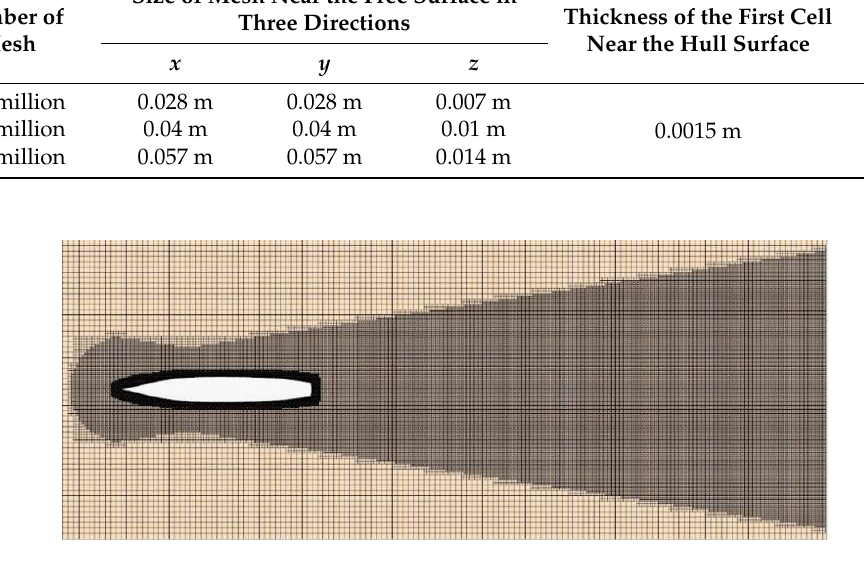
Figure 4. Mesh arrangement for intact ship case (medium mesh).